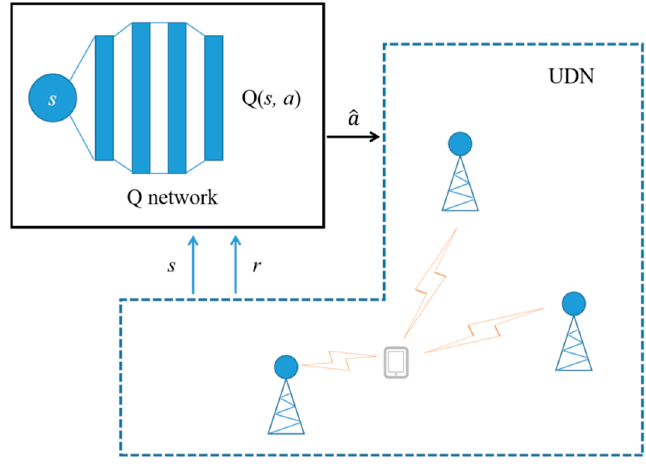
Figure 1. The DQN algorithm.